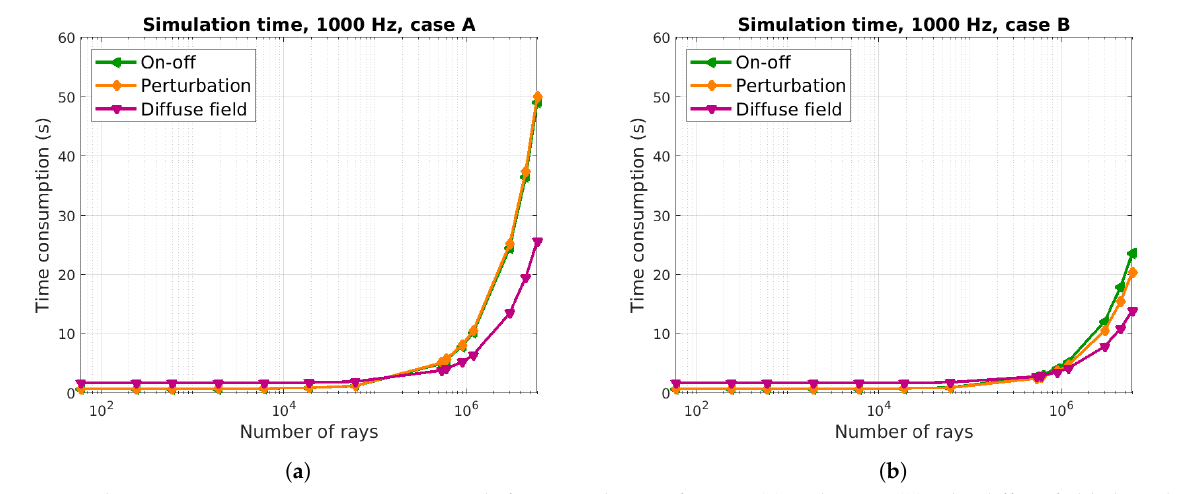
Figure 8. The average time consumption in seconds for a simulation of case A ( a ) and case B ( b ). The diffuse field algorithm takes longer to run for a small number of rays, but is faster when a large number of rays are